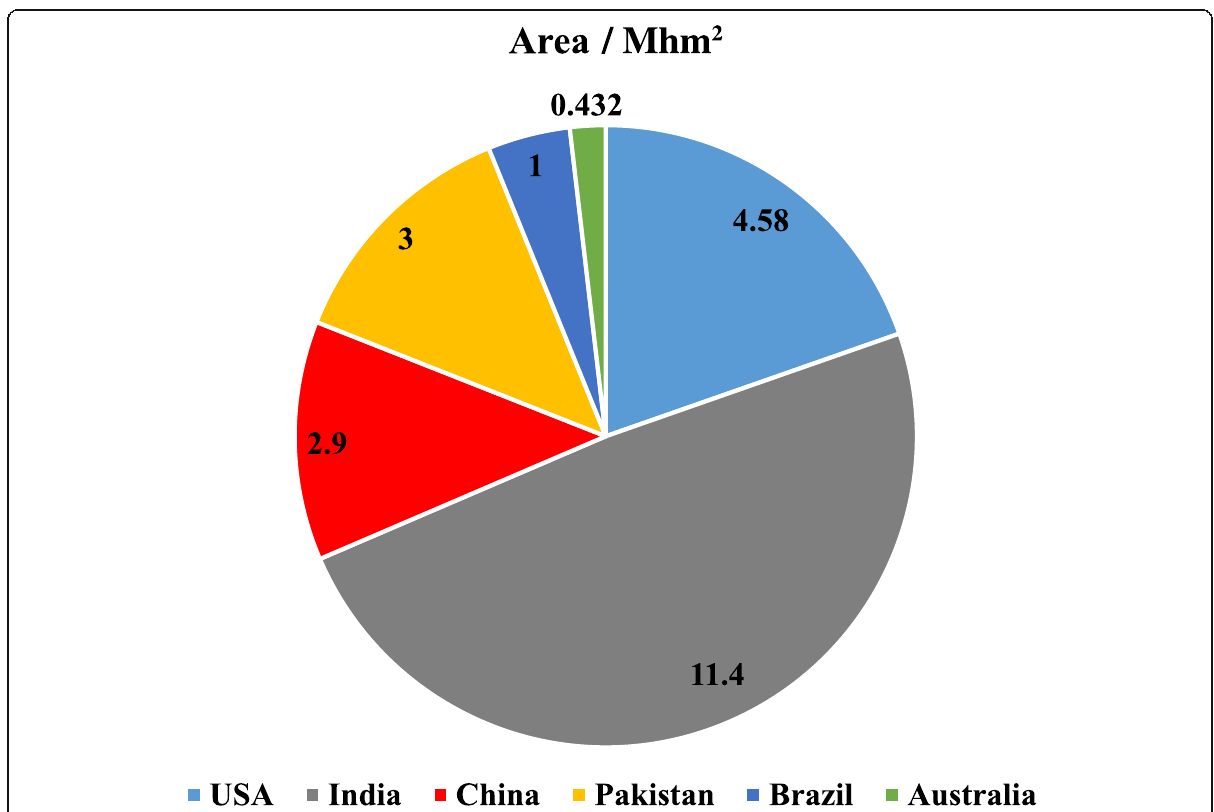
Fig. 1 Bt cotton planted area (million hectares) in major cotton producing countries (ISAAA